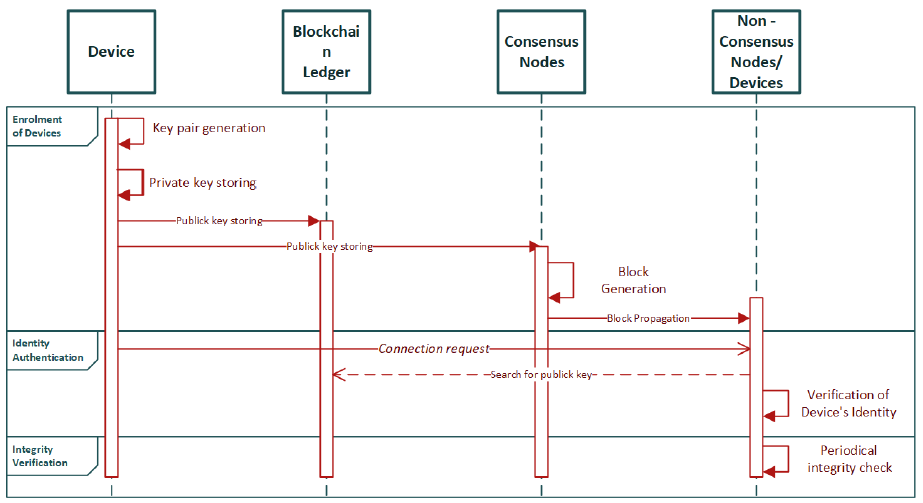
Figure 4. Sequence diagram of the proposed scheme in [38].